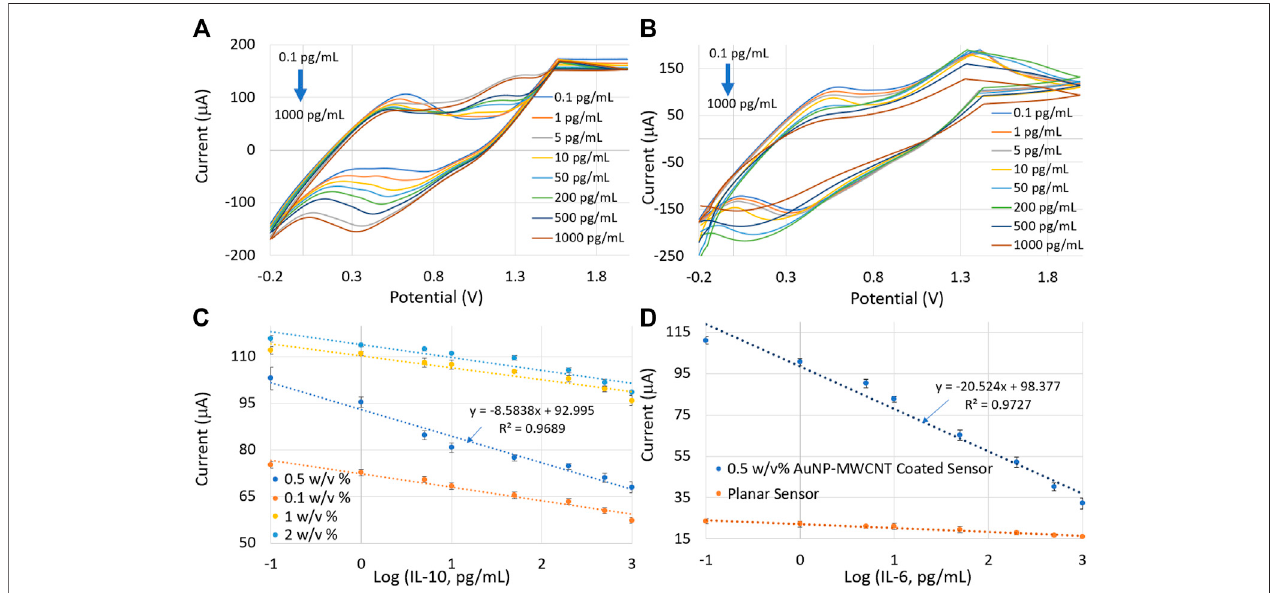
FIGURE 5 | CV plots from the 0.5% (w/v) AuNP-MWCNT-coated sensor for eight different concentrations of (A) IL-10 and (B) IL-6. (C) Calibration curves by plottingcurrentversusproteinconcentrationsforfourdifferentAuNP-MWCNTcoatings. (D) CalibrationplotsshowingtheperformancecomparisonofplanarandAuNP- MWCNT-coated IL-6 sensors. Error bars represent three repeated measurements for each protein concentration.